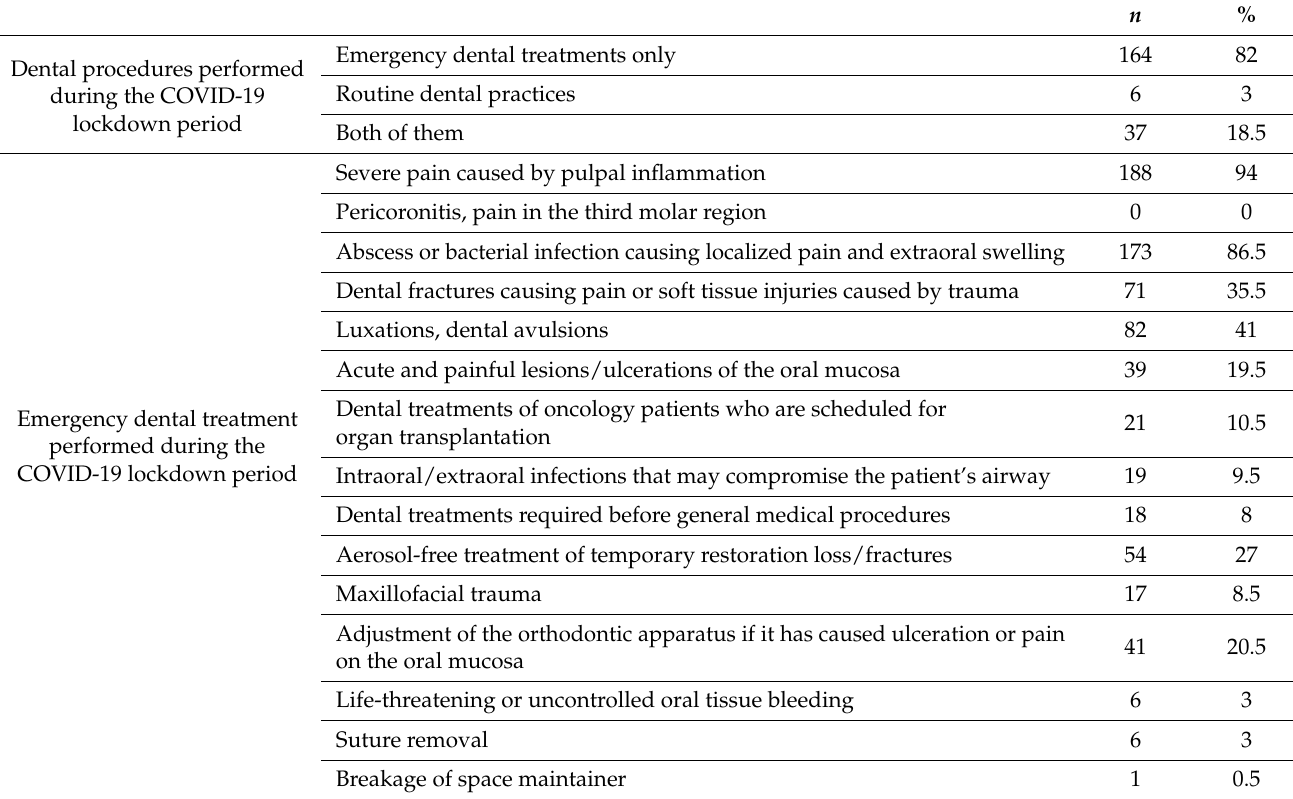
Table 7. Emergency situations encountered by participants during the COVID-19 pandemic period.